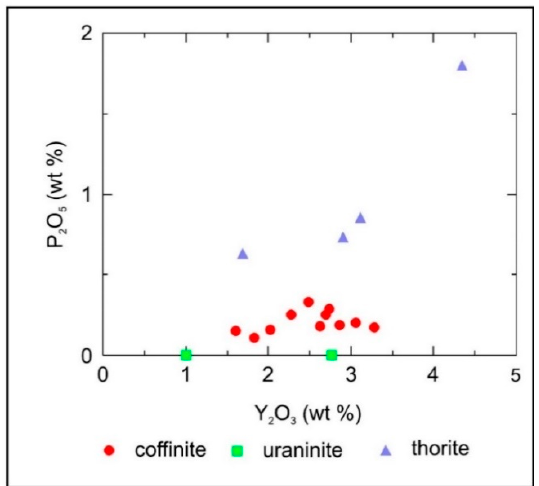
Figure 12. Plot of P 2 O 5 vs. Y 2 O 3 for coffinite, uraninite, and thorite from the Nahošín and Me č ichov uranium deposits.